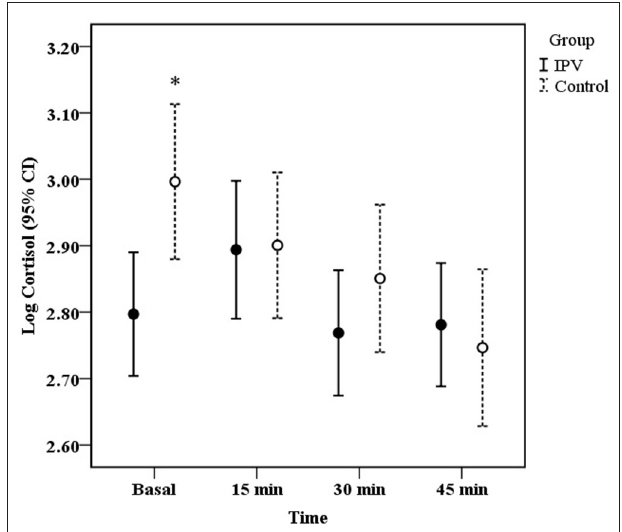
FIGURE 1 | Mean ( ± 95% CI) of salivary cortisol concentration before (basal), and 15, 30, 45min after the onset of the cognitive test in women with IPV (bold circle, N = 71) and control without IPV (open circle, N = 59). * P < 0.05 vs. 45min.